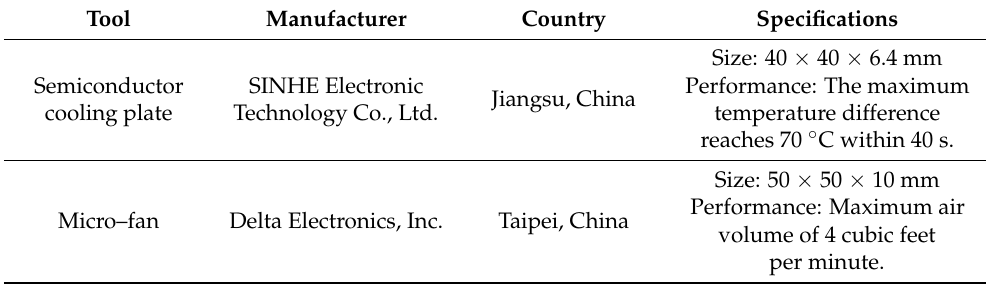
Table 1. Information about major components.